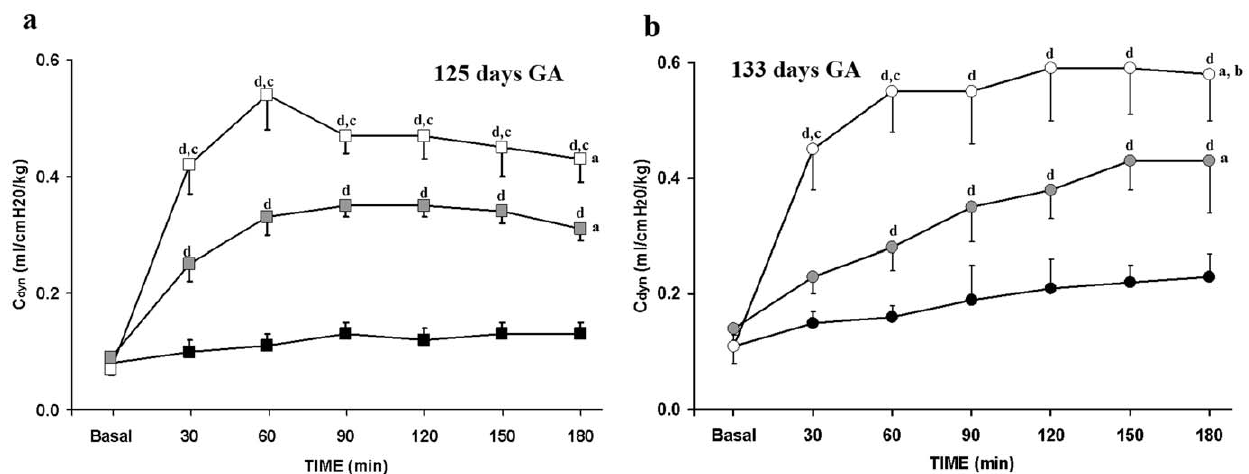
Figure 3. Pulmonary mechanics in premature lambs at two of gestational ages. Mean dynamic compliance; C dyn (a) at 125 days of GA in Control-125d [indicated by black squares]; surfactant, SF-125d [indicated by grey squares]; and partial liquid ventilation, PLV-125d [indicated by white squares] groups. Mean C dyn (b) at 133 days of GA in Control-133d [indicated by black circles]; surfactant, SF-133d [indicated by grey circles]; and partial liquid ventilation, PLV-133d [indicated by white circles] groups. Fetal: indicates the fetal values in each group, while the lambs are still connected to the placenta. Baseline: shows pre-treatment values before pulmonary treatment. Values are given as mean 6 SEM. Significant differences are indicated by: ( a ) vs. Control group, P , 0.05, two-way ANOVA over all time points; ( b ) vs. SF group, P , 0.05, two-way ANOVA over all time point; ( c ) vs. SF group, P , 0.05, one-way ANOVA at each time point; and ( d ) vs. Control group, P , 0.05, one-way ANOVA at each time point.